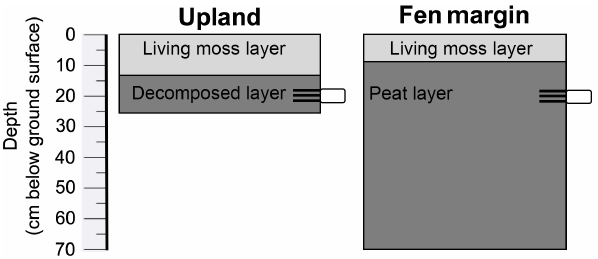
Figure 2. Moisture probe profiles in upland duff and fen margin